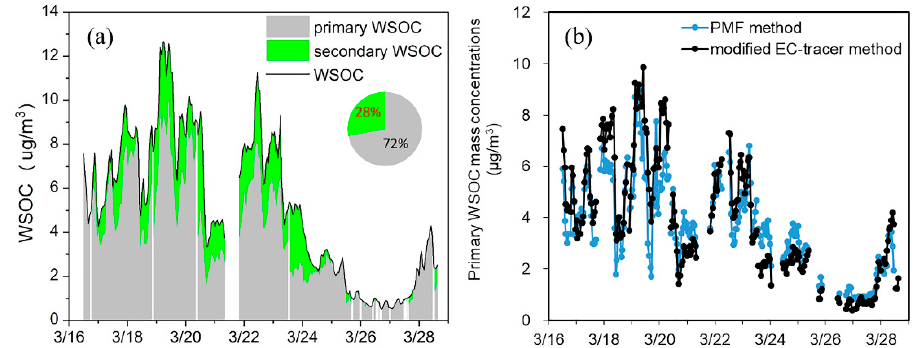
Figure 5. ( a ) Time series of WSOC from primary and secondary sources and their average contributions during the study period, which was calculated by the modified EC-tracer method. ( b ) Primary WSOC estimated by the modified EC-tracer method and the PMF method.